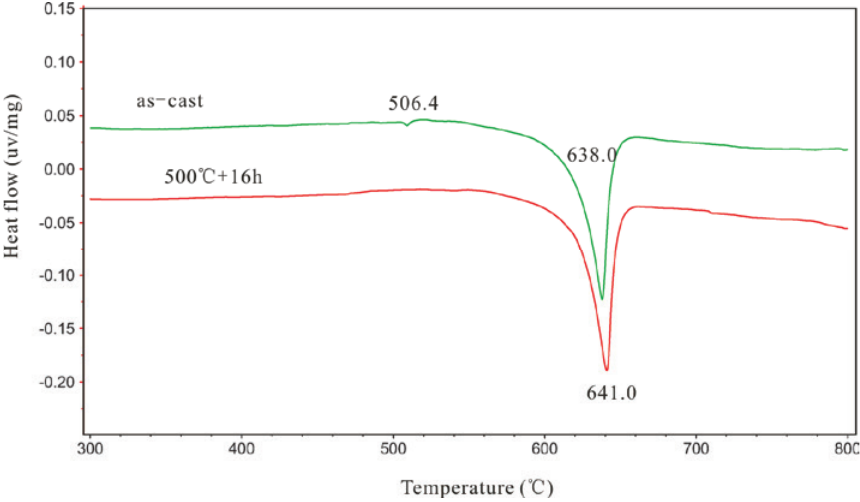
Fig. 5: DSC curves of as-cast alloy 2618 and the alloy homogenized at 500 °C for 16 h